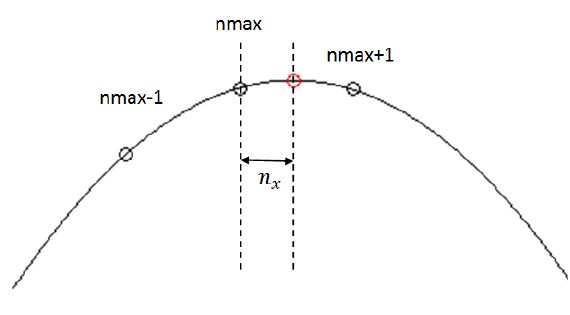
Figure 7. Parabolic interpolation using a buffer size of 3 samples to obtain the maximum of the signal